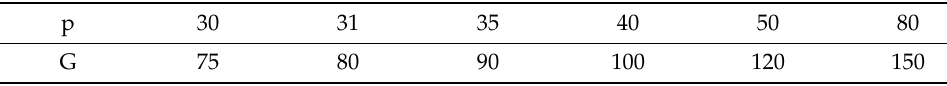
Table 8. Passport characteristics of the existing